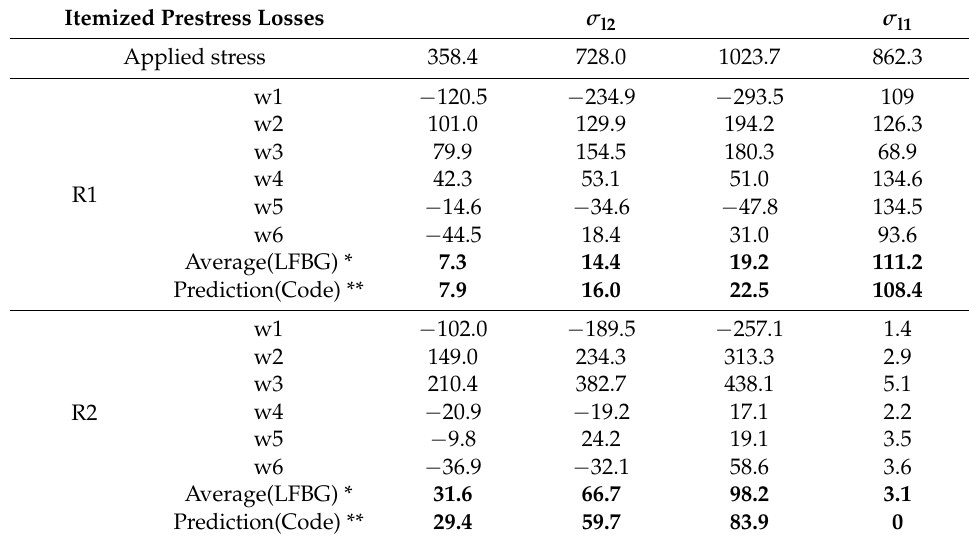
Table 12. σ l2 and σ l1 calculated from the strains of the LFBG sensors. (Units: MPa). Itemized Prestress Losses σ l2 σ l1 Applied